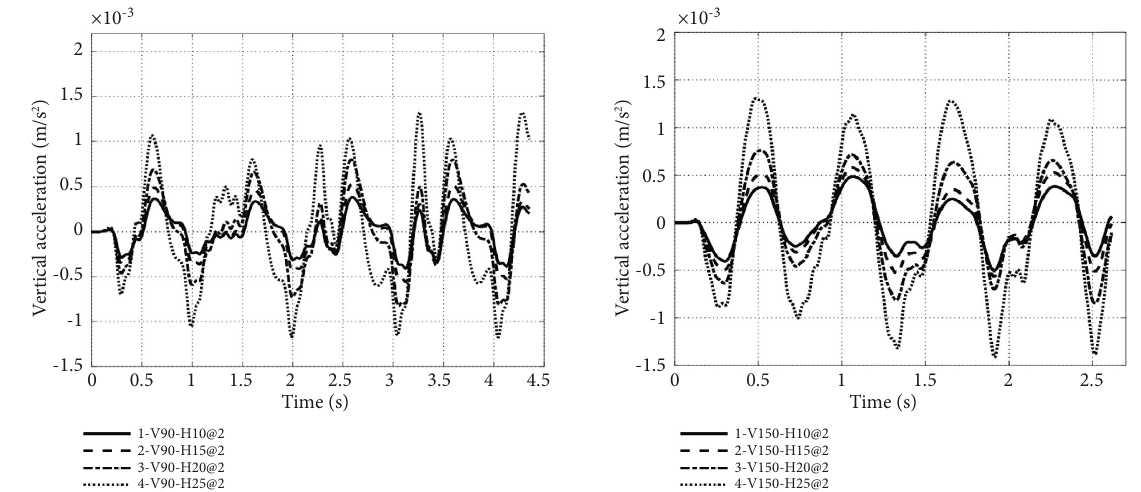
Figure 16: Vertical acceleration response of pickup point under thickness change of vibration isolation